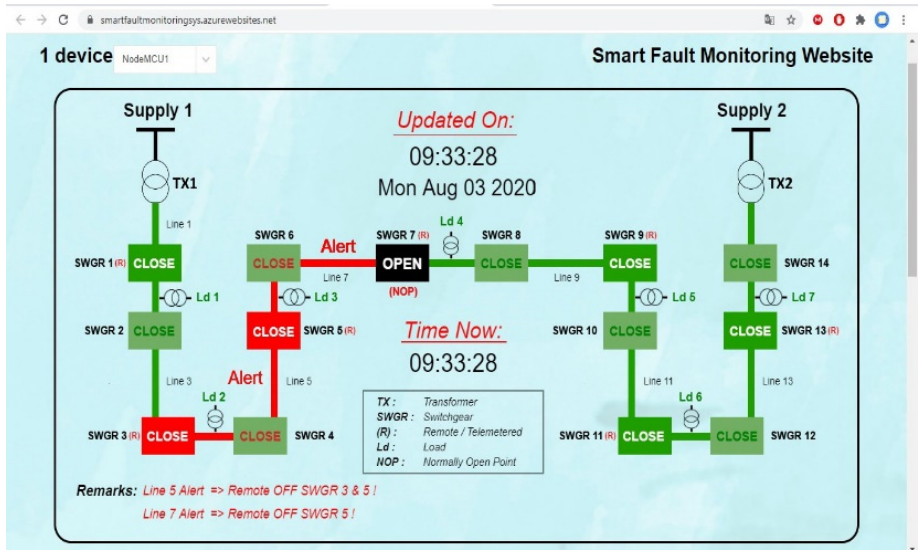
Figure 20. Smart fault monitoring website with faults on lines 5 and 7.